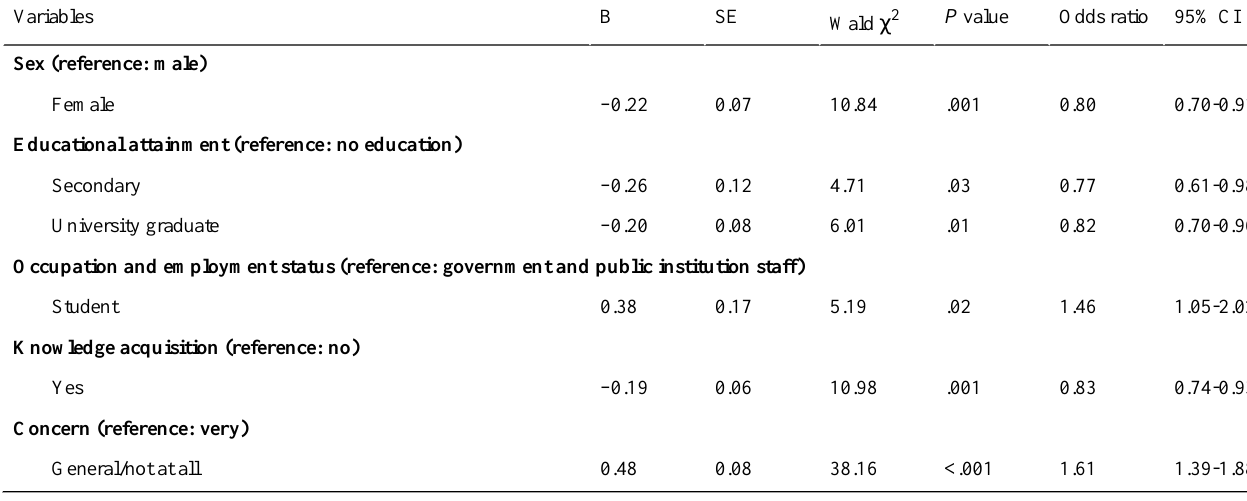
Table 5. Multivariate logistic regression of factors that contributed to performing preventive